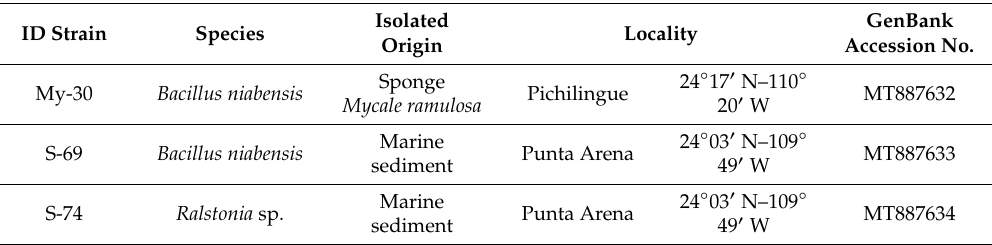
Table 1. Marine bacteria isolated from sponge and sediment of coasts of Baja California Sur (with antifouling